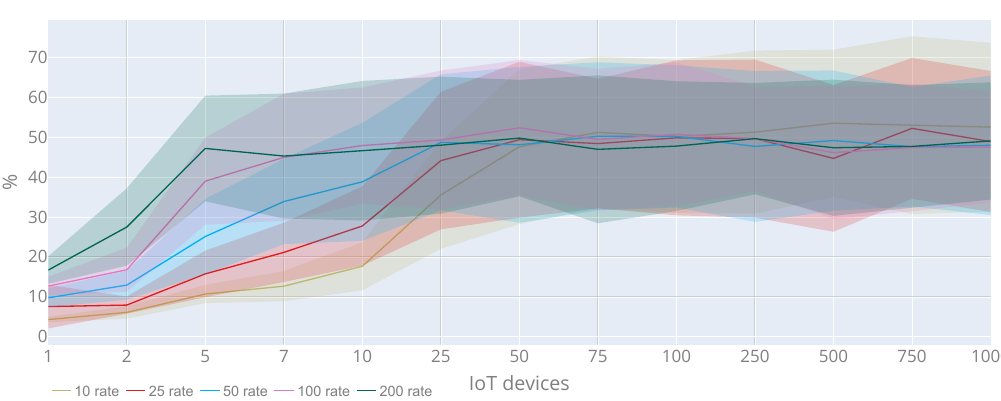
Figure 17. CPU utilisation of the observations injection with a rate of requests 10, 25, 50, 100 and 200 requests per